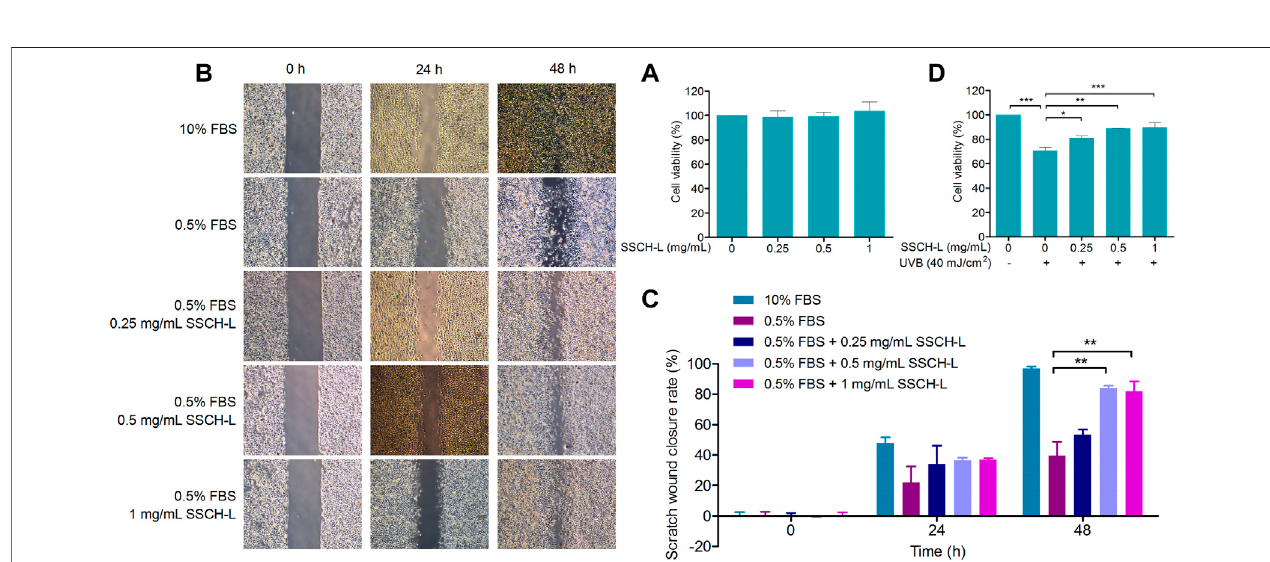
FIGURE4| TheeffectsofSSCH-Latdifferentconcentrations (A) ontheviabilityand (B) themigrationofL929cells. (C) Thewoundclosureratewascalculatedat0, 24, and 48 h after scratching. (D) The protective effects of SSCH-L on L929 cells damaged by UVB radiation. The error bars refer to standard deviations obtained from the triplicate sample